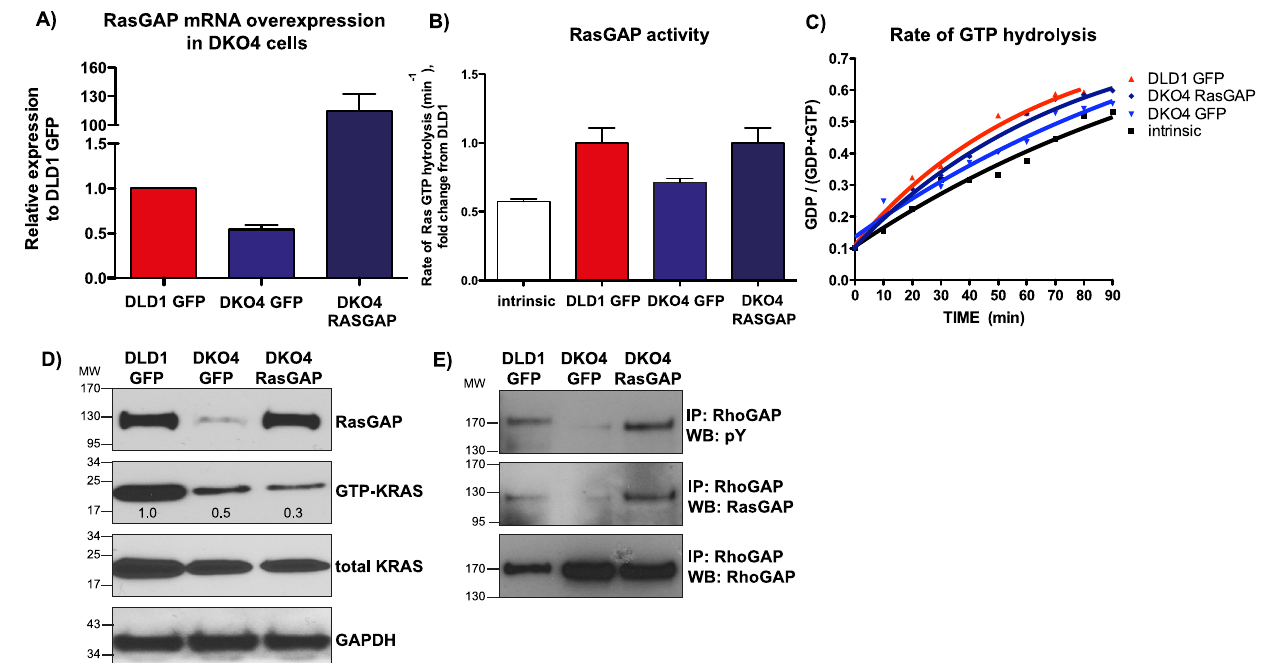
Figure 4. Overexpression of RasGAP expression in DLD1 cells rescues RhoGAP phosphorylation and overall GAP activity. A) mRNA expression of RasGAP after overexpression in DKO4 cells compared to the GFP vector control. B) Real-time NMR analysis of RasGAP activity, showing mean rate of GTP hydrolysis (B) and GAP activity over time (C). Each curve in (C) is derived from a single representative experiment. Error bars in (B) denote standard error of the mean (SEM). D) RAS activity assay showing levels of active KRAS after RasGAP overexpression. Numbers denote densitometry values from this blot, which is representative of three biological replicates. E) RhoGAP was immunoprecipitated from cell lines, subjected to Western blotting, then probed for total phosphotyrosine, RasGAP and